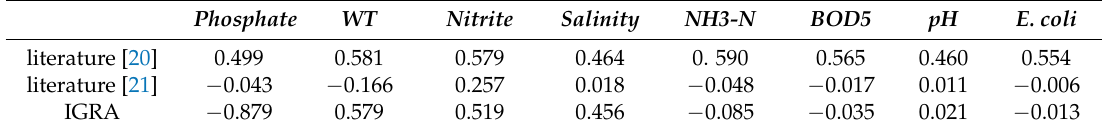
Table 2. The relational analysis results of Victoria